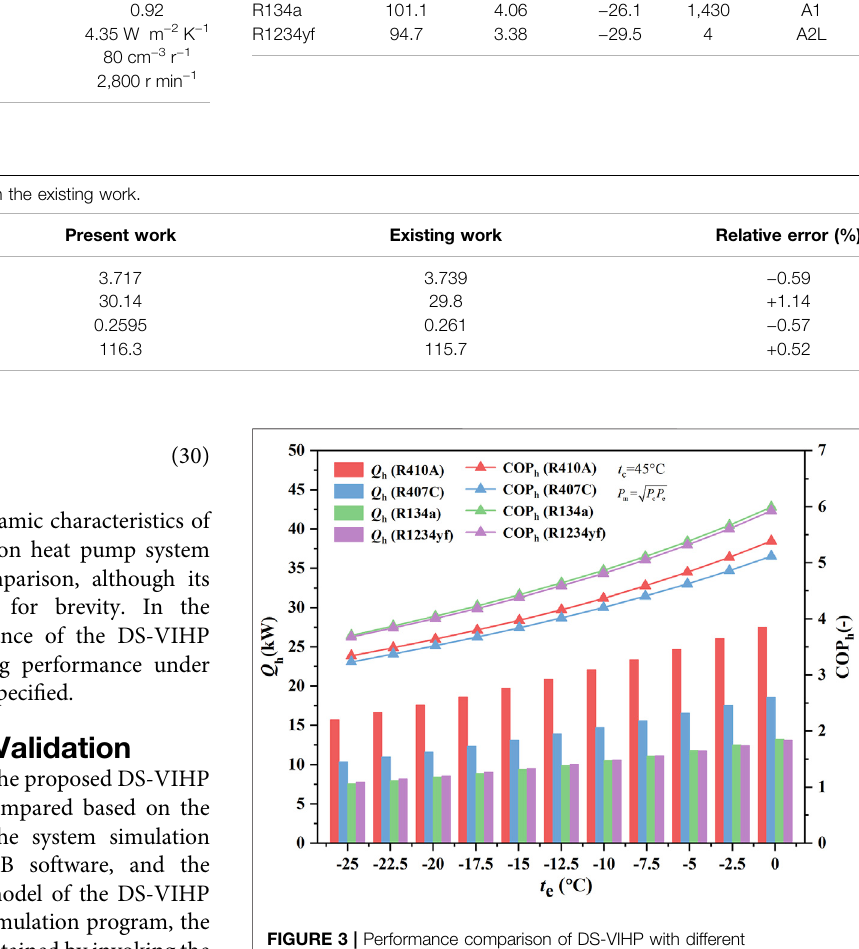
FIGURE 3 | Performance comparison of DS-VIHP with different